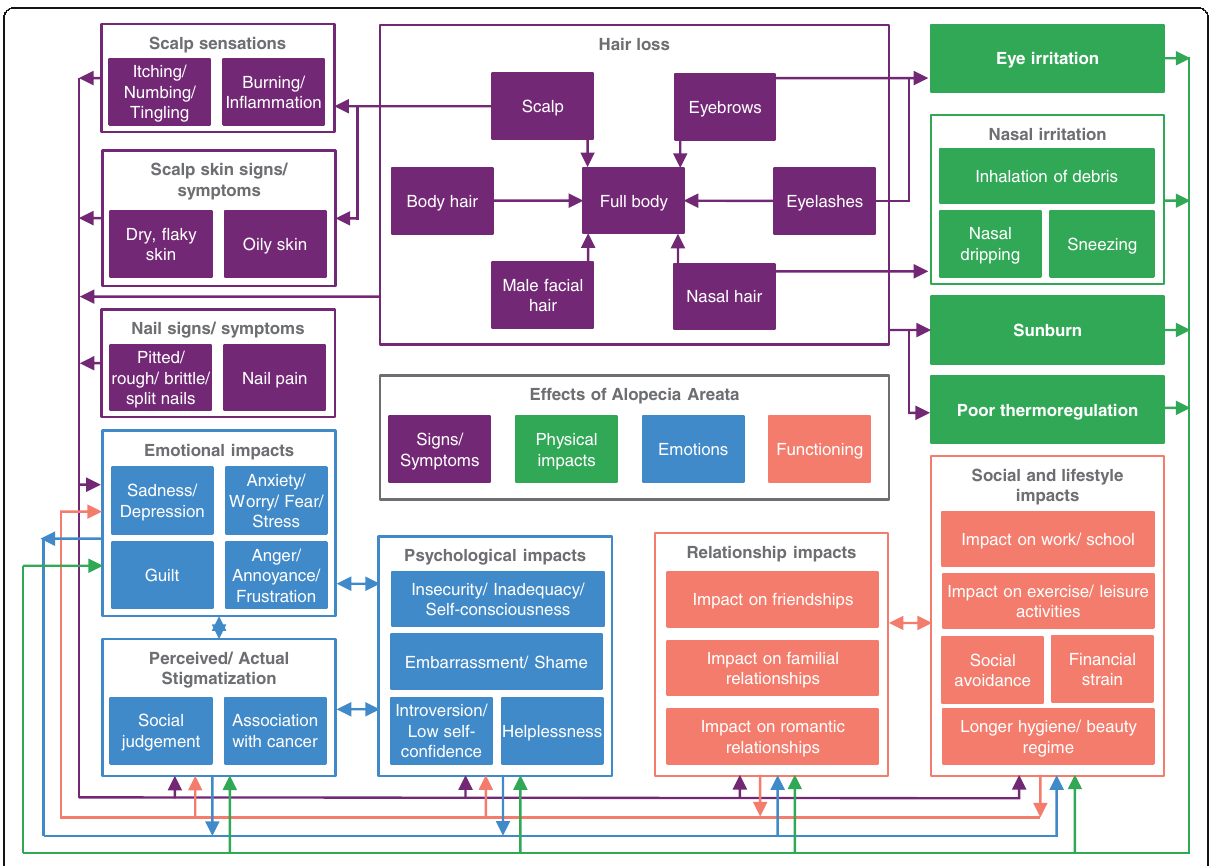
Fig. 2 Conceptual model of the effects of alopecia